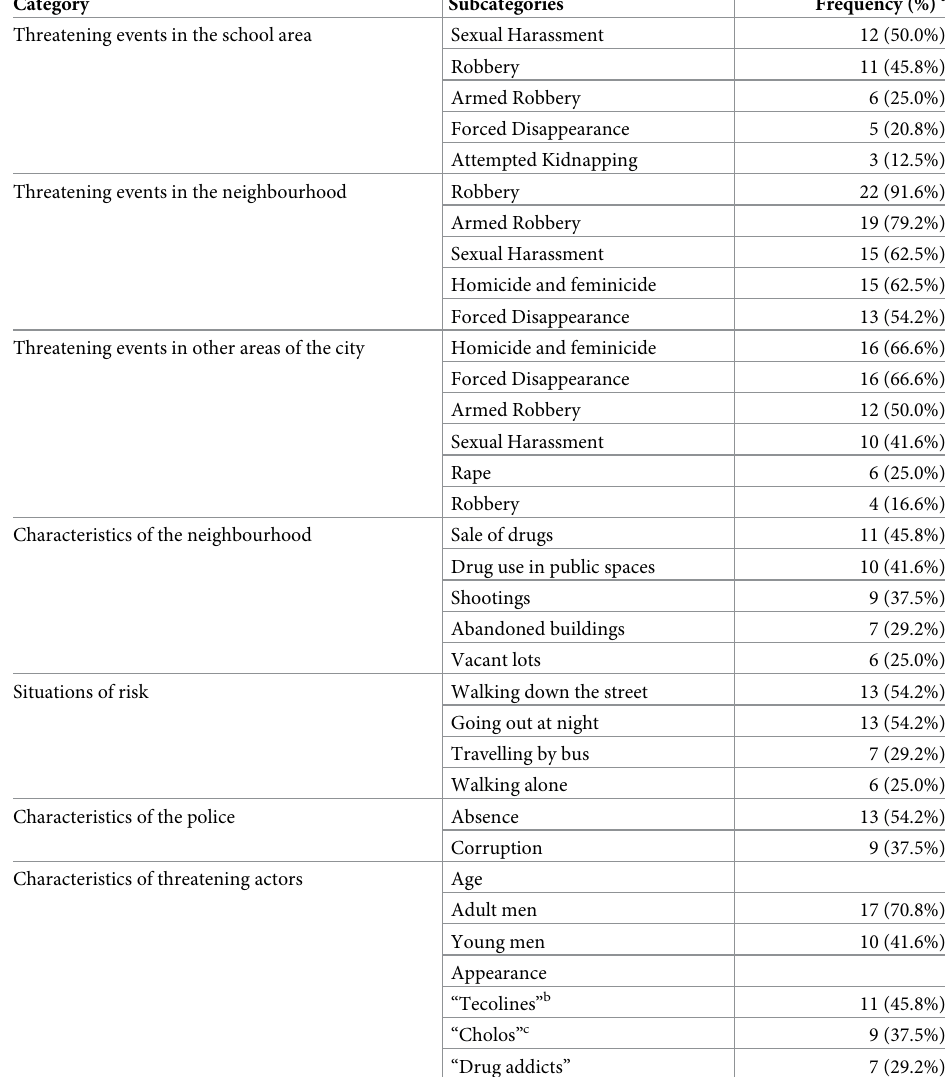
Table 2. Contextual conditions of feelings of insecurity in public spaces: Main categories and subcategories across groups (n =